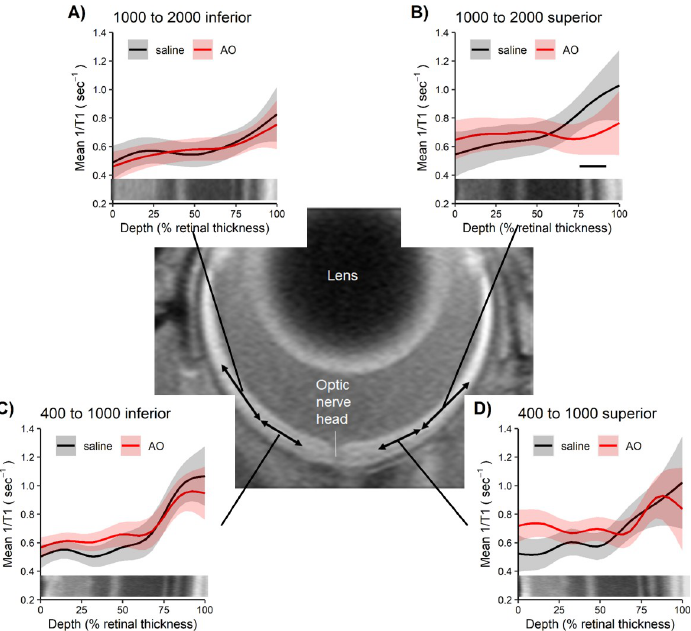
Fig 3. QUEST MRI showing oxidative stress localized to peripheral superior retina. Modeled 1/T1 profiles approximately 1 hour post-sildenafil IP in light-adapted mice given either saline (n = 4 mice, black line) or anti- oxidants (AO, n = 5 mice, red line) in these four retinal regions: A) 1000 to 2000 inferior, B) 1000 to 2000 superior, C) 400–1000 inferior, and D) 400–1000 superior; representative OCT images (bottom of each graph) provide spatial orientation. Only significant (horizontal black bar) AO reductions in 1/T1 indicative of oxidative stress are shown. Each profile has a solid line indicating the mean and a shaded region indicating 95% confidence